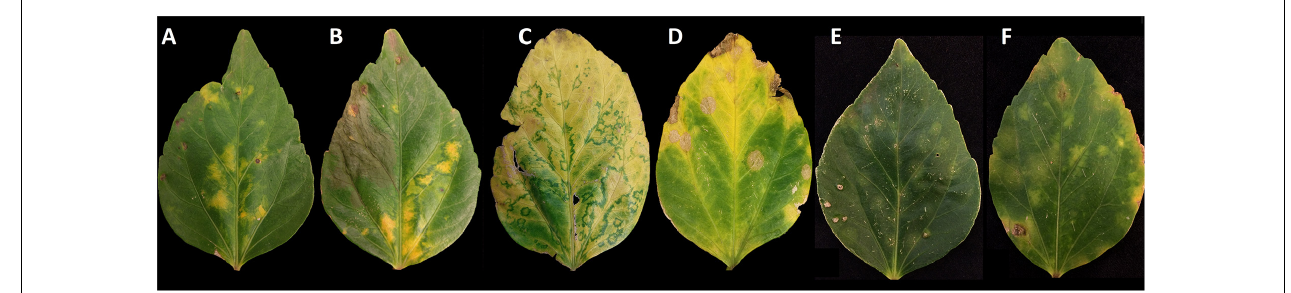
FIGURE 1 | Variation in lesion symptoms displayed by Hibiscus rosa-sinensis leaves infected by hibiscus yellow blotch virus. Yellow blotches developed on mature leaves, and a dark green perimeter became visible as the leaves senesced. Lesions observed in panels (A,B) were predominant in July 2019; lesions observed in panels (C,D) were predominant in November 2019; lesions in panels (E,F) were predominant in March 2020. The lesions observed in panel (D) present a necrotic center that was sometimes observed in senescent